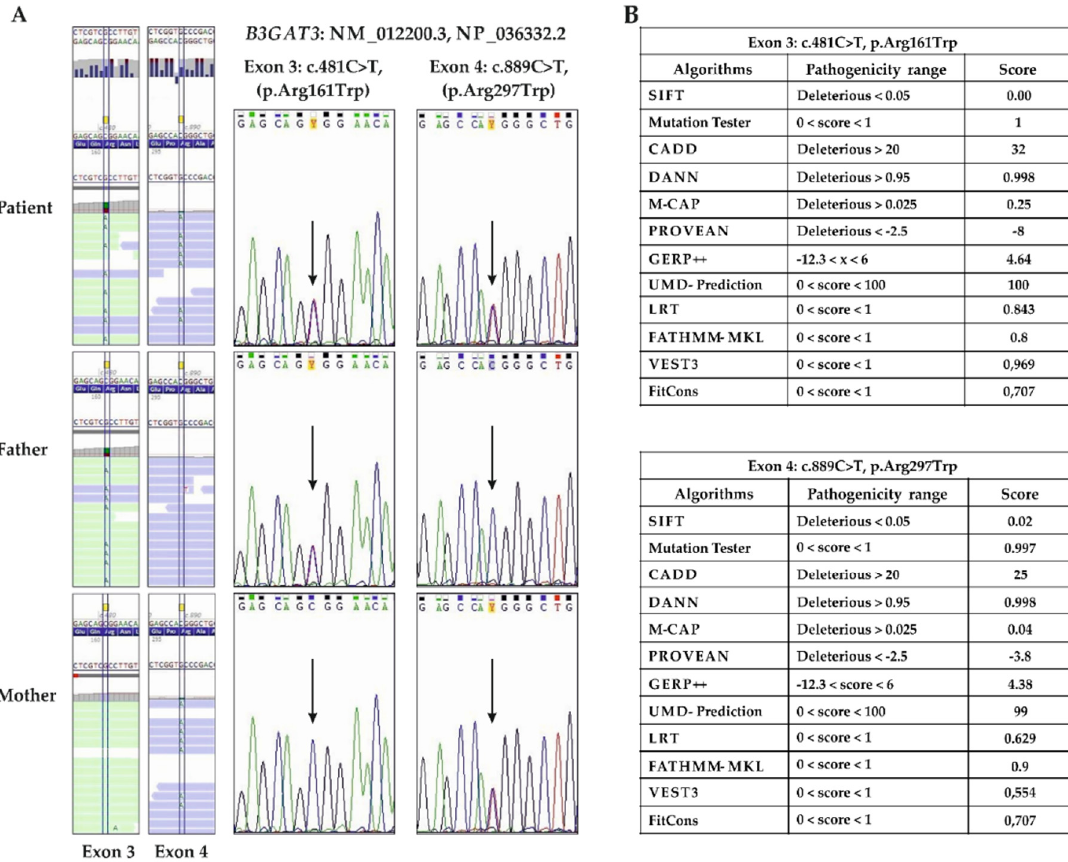
Figure 3. Molecular findings. ( A ) ES data alignments show the compound heterozygosity of the paternal c.481C > T (p.Arg161Trp) and the maternal c.889C > T (p.Arg297Trp) missense variants. Sanger sequencing confirmed the presence of both variants in the proband (arrows). Healthy parents were heterozygous carriers. Mutations are annotated according to HGVS nomenclature (reference sequences: NM_012200.3, NP_036332.2). ( B ) In silico predictions of the pathogenicity of the p.(Arg161Trp)